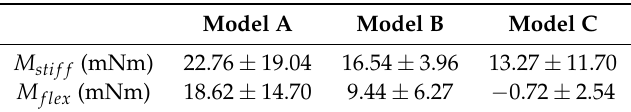
Figure 6. Histograms of the total torque of the three stern models and their stiff counterparts. While in model A the mean value is not reduced by much, the torque’s overall amplitude is reduced significantly. In model B, the mean shifts to lower values, but the total amplitudes are increased. This is caused by the very flexible model, resulting in high vibrations. In model C, the shift to lower torque values, and therefore less yaw, is significant. The amplitude of the oscillations is also slightly reduced. Table 3. Experimental results, showing the mean values ± standard deviation of the total torque M for the stiff and the flexible stern